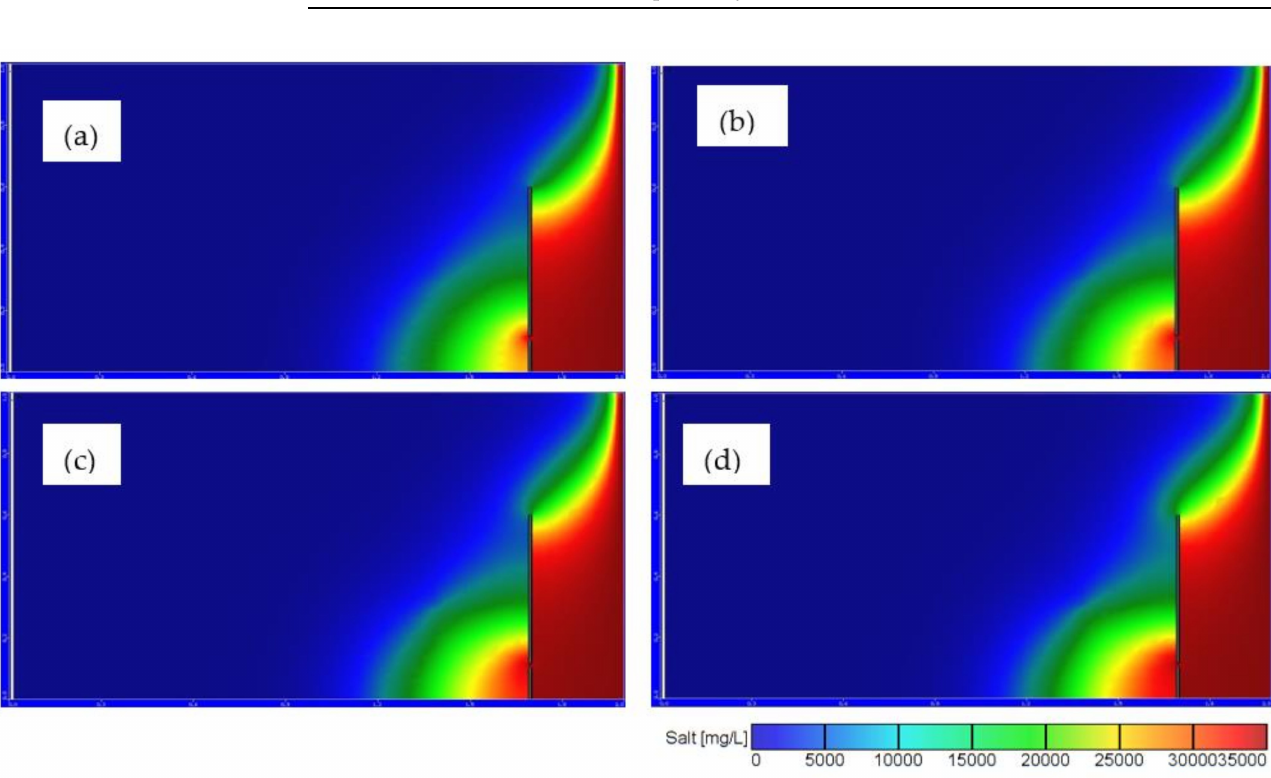
Figure A1. Salinity distribution for D f = 0.005 m, H f = 0.1 m, L d = 0.5 m, L w /L d = 1.0, for subsurface dam location L d = 30 cm and for different values of abstraction rates: ( a ) 2 × 10 − 6 ( b ) 3 × 10 − 6 , ( c ) 4 × 10 − 6 , and ( d ) 5 × 10 − 6 m 3